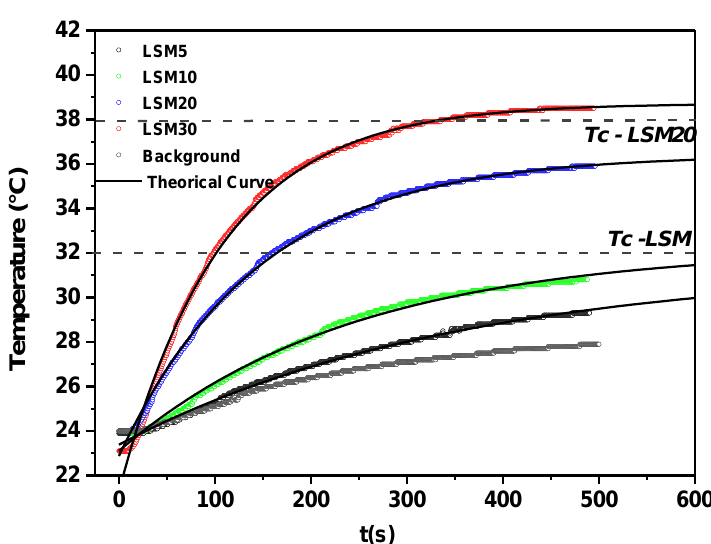
Figure 13. Temperature vs. heating time dependences for composite samples accuracy ± 0.5 °C.